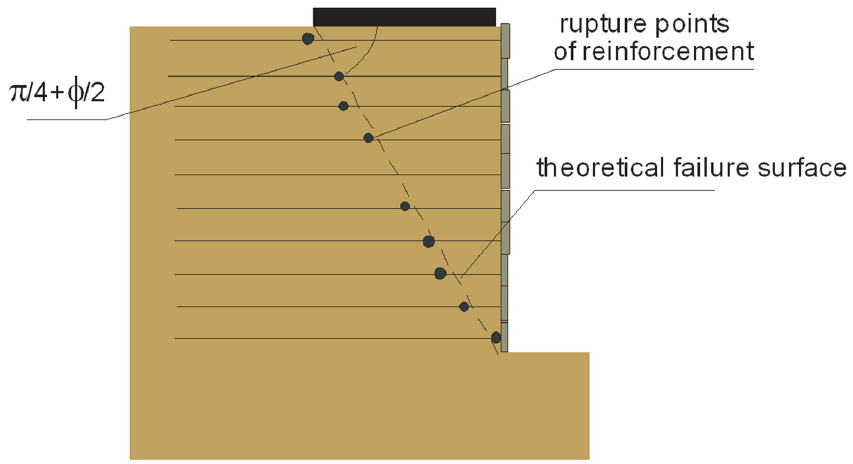
Figure 9. Experimental and theoretical Rankine failure